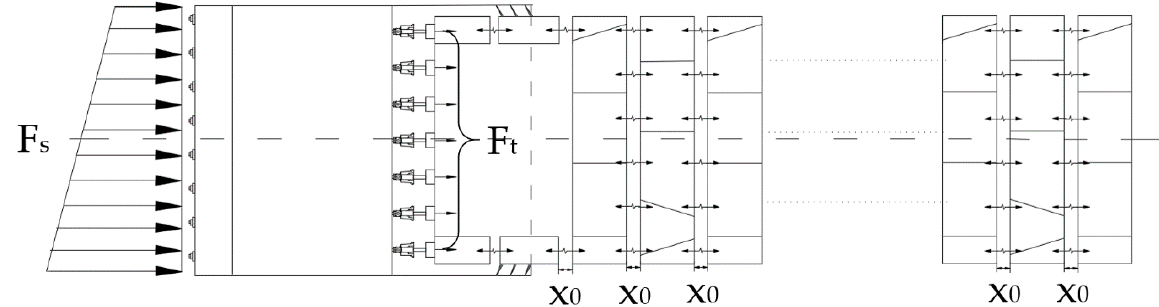
Figure 1. Schematic diagram of segment rings and circumferential joints under shield thrust. In the process of shield underground docking, the disassembly operation will cause shield thrust unloading. The sealing gaskets, rubber gaskets and longitudinal bolts between segment rings will be stretched longitudinally under the action of segment weight and friction force f, and the opening of the circumferential joint will change to x i . The load characteristics and longitudinal compression forces of the segment ring change, eventually reaching a new equilibrium, as shown in Figure